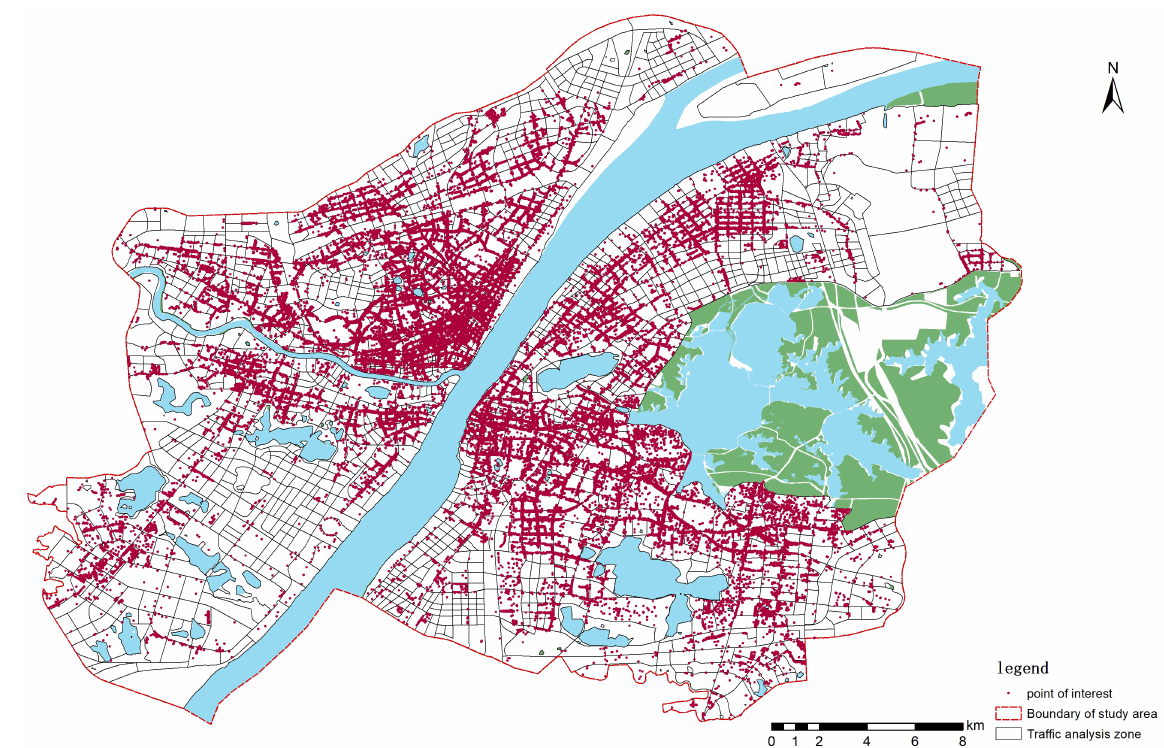
Figure 7. Spatial distribution of